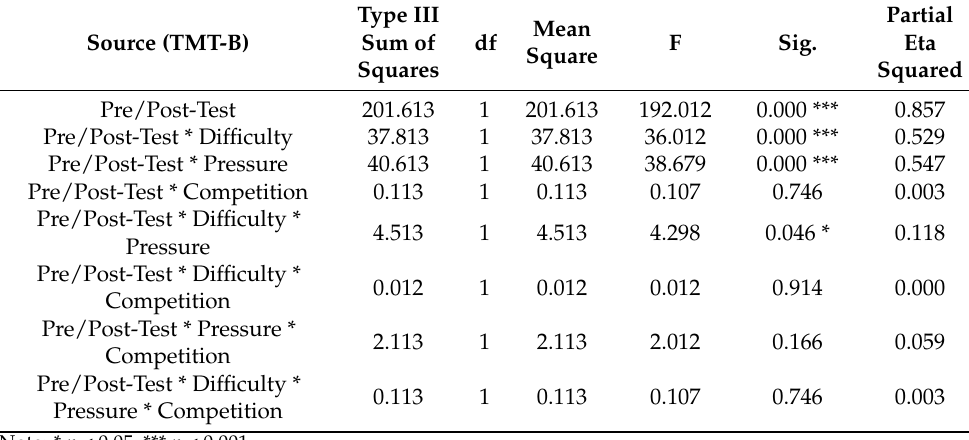
Table 21. Tests of within-subject effects of TMT-B.